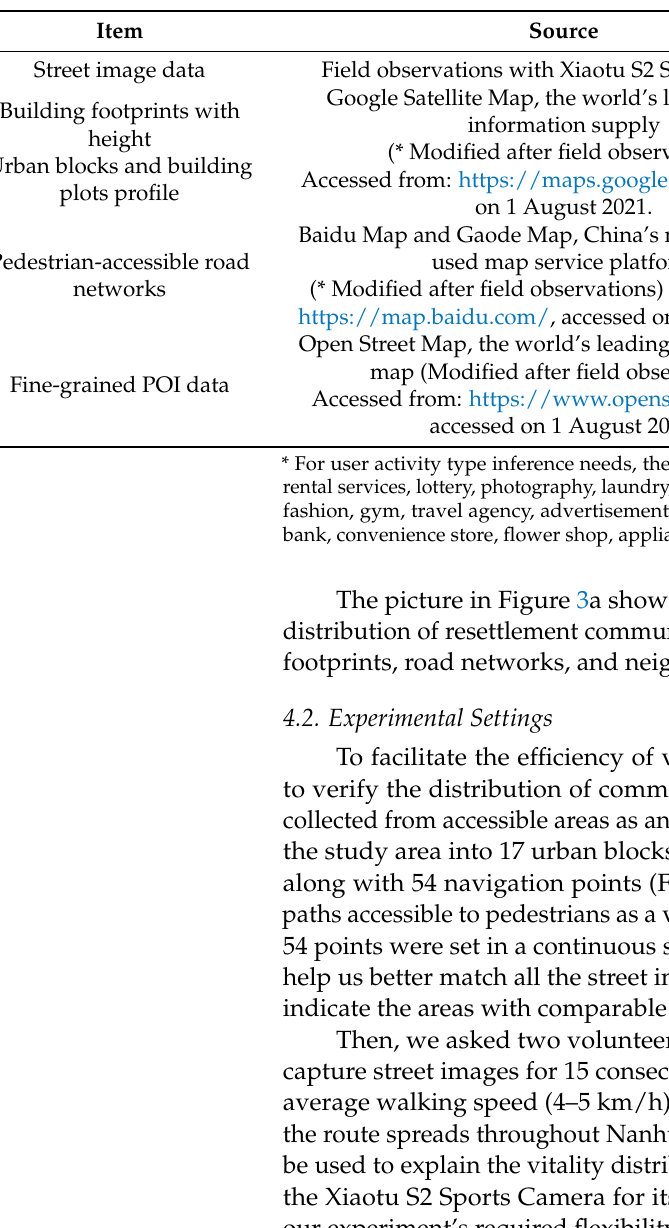
Table 5. A detailed description of the data source used in our empirical